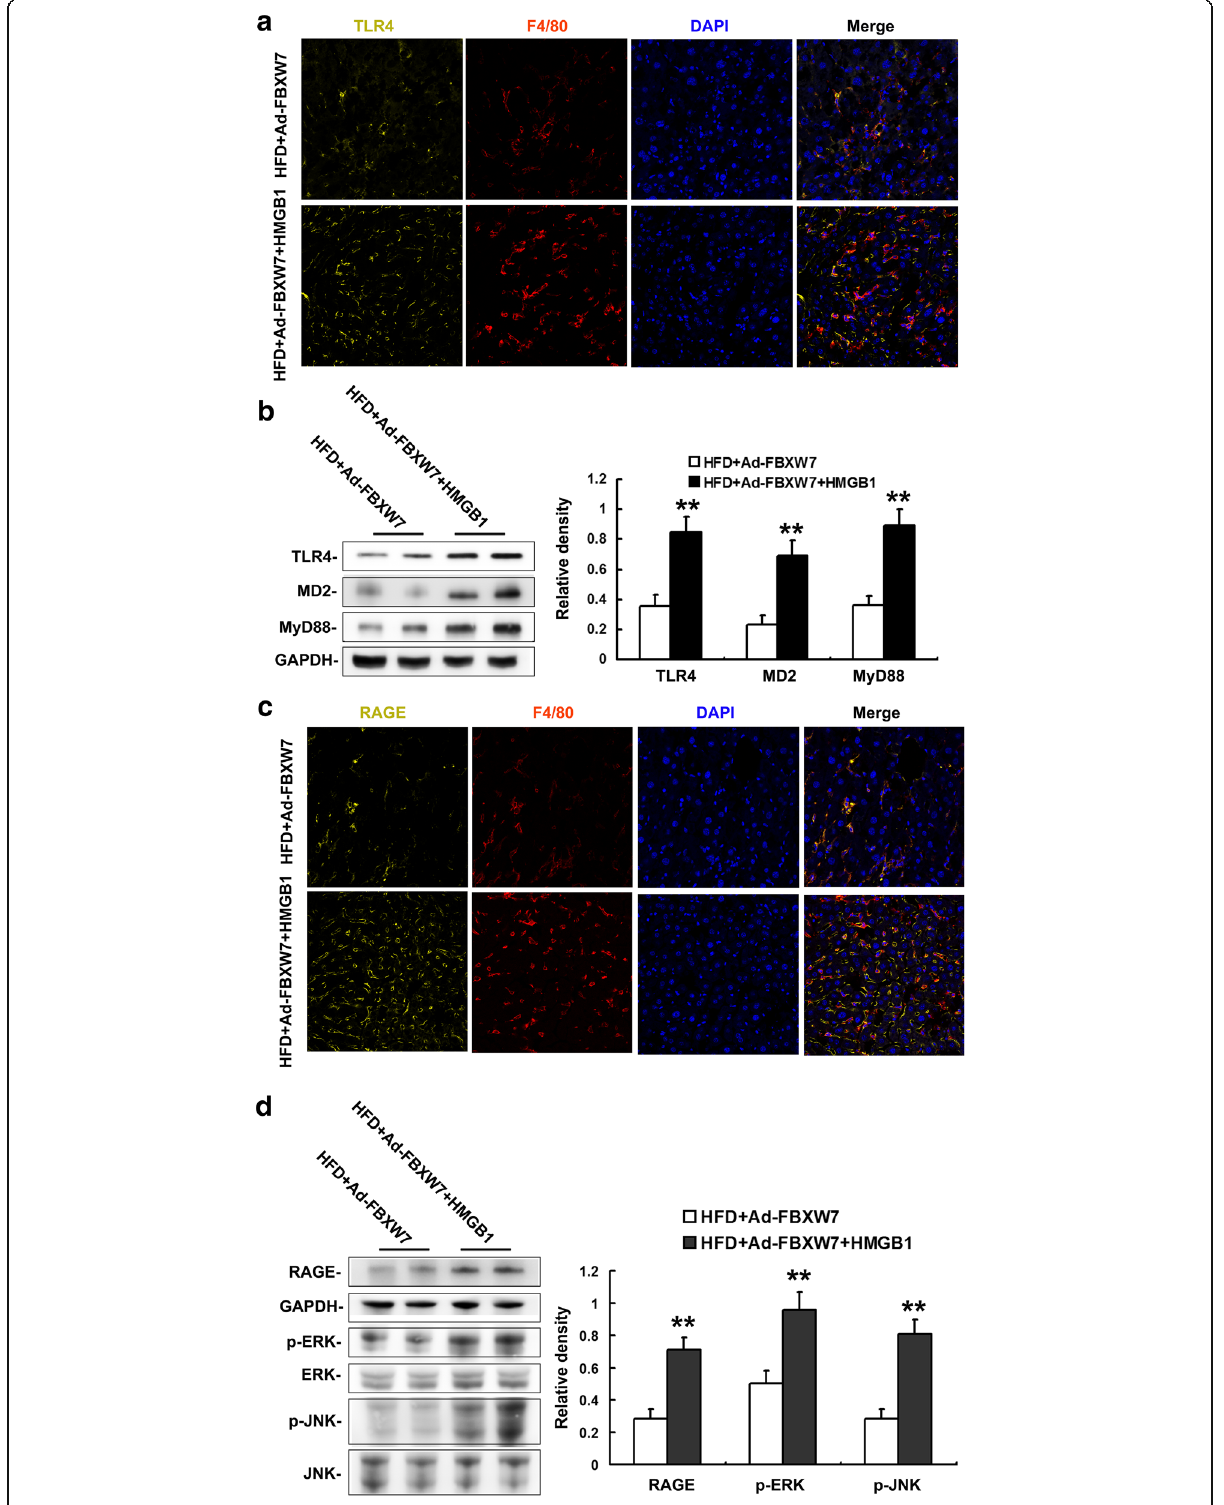
Fig. 8 (See legend on next